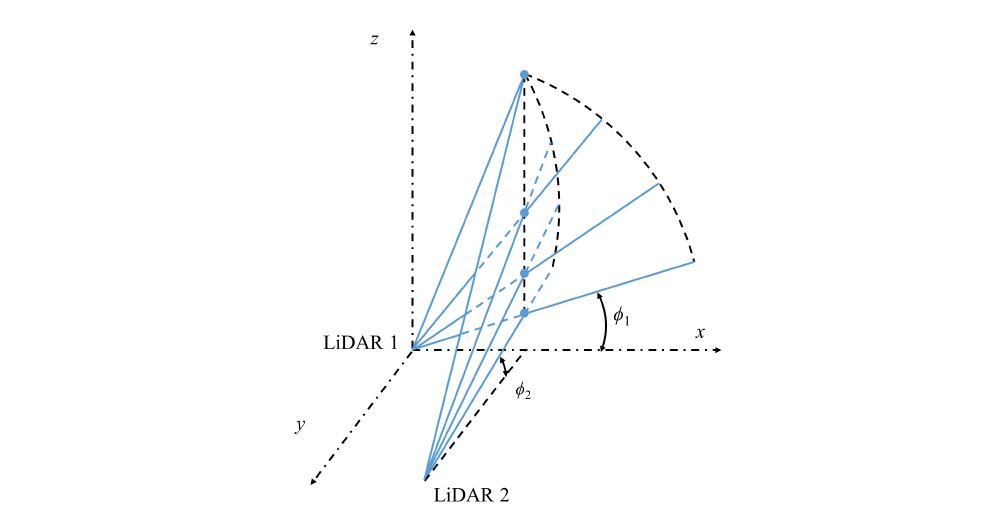
Figure A3. Schematic diagram of a dual LiDAR scan. Blue solid circles represent the intersecting points of two LiDAR